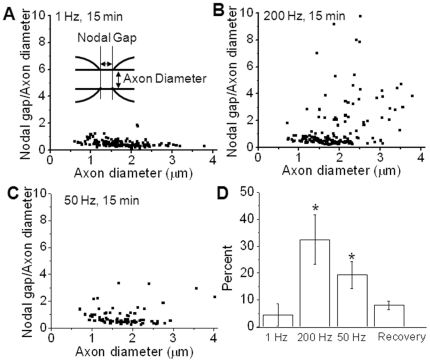
Dependence of paranodal myelin retraction on stimulation frequency.(A) Inset: Diagram of node of Ranvier defining parameters measured. Plot: Scatter-plot of ratio of Nodal Gap/Axon Diameter versus Axon Diameter for spinal tissue samples stimulated at 1 Hz for 15 min (8 samples, 144 nodes total) (B) Scatter-plot of ratio of Nodal Gap/Axon Diameter vs. Axon Diameter for samples stimulated at 200 Hz for 15 min (4 samples, 150 nodes total). Plot shows that at 200 Hz, larger axons are more susceptible to retraction evidenced by the increased ratio for larger axon diameters. (C) Scatter-plot of ratio of Nodal Gap/Axon Diameter vs. Axon Diameter for samples stimulated at 50 Hz for 15 min in normal Krebs' (n = 3, 76 nodes total). (D) Bar graph of percentage of nodes showing retracted morphology. Samples stimulated at 1 Hz, 200 Hz, and 50 Hz for 15 min show 4±4%, 32±9%, and 19±5% of nodes with retracted morphology, respectively. After a 2 h recovery period, myelin retraction was reduced to 8±2%. * indicates data with significant difference (p<0.01, One-way ANOVA).